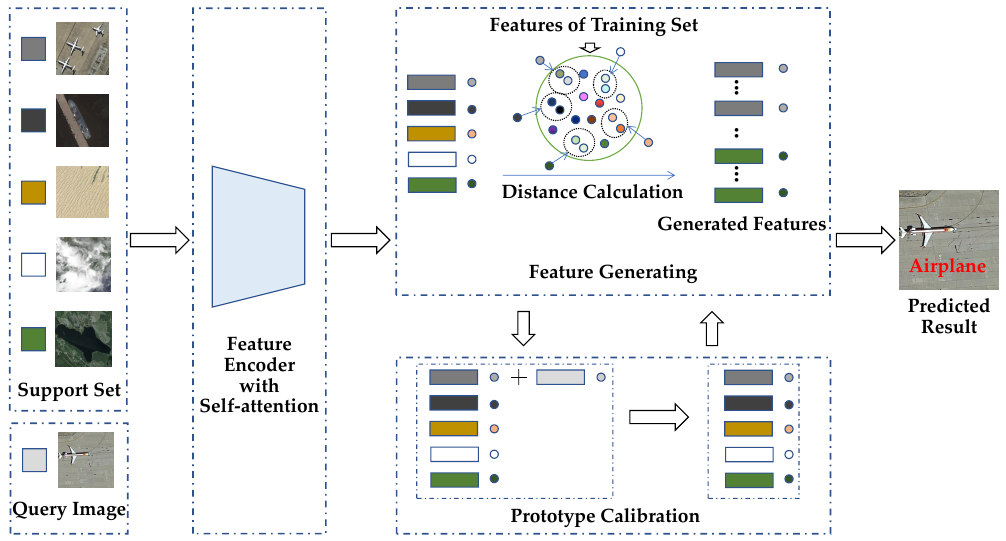
Figure 2. The overview of prototype calibration with feature-generating